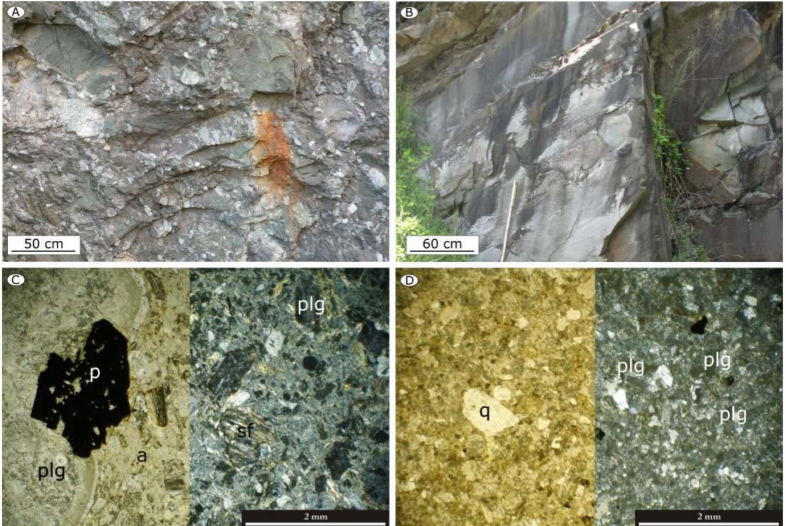
Figure 7. ( A ) Coarse-grained pyroclastic density current deposit of the Val d’Aveto Formation- Petrignacola Formation. ( B ) Thick volcanogenic sandstones of the Val d’Aveto-Petrignacola For- mation. ( C ) Thin section of a pyroclastic density current deposit of the Val d’Aveto-Petrignacola Formation, crossed nichols on the left. ( D ) Thin section of a volcanogenic sandstone of the Val d’Aveto-Petrignacola Formation, crossed nichols to the left. Large amounts of particles, plastically deformed, form a typical pseudomatrix and indicate short time between the production of detritus and its accumulation underwater. All the photos are modified from [70]. Plg = plagioclase; p = pyrite; q = quartz; a = amphibole; sf = phengite-bearing schist rock